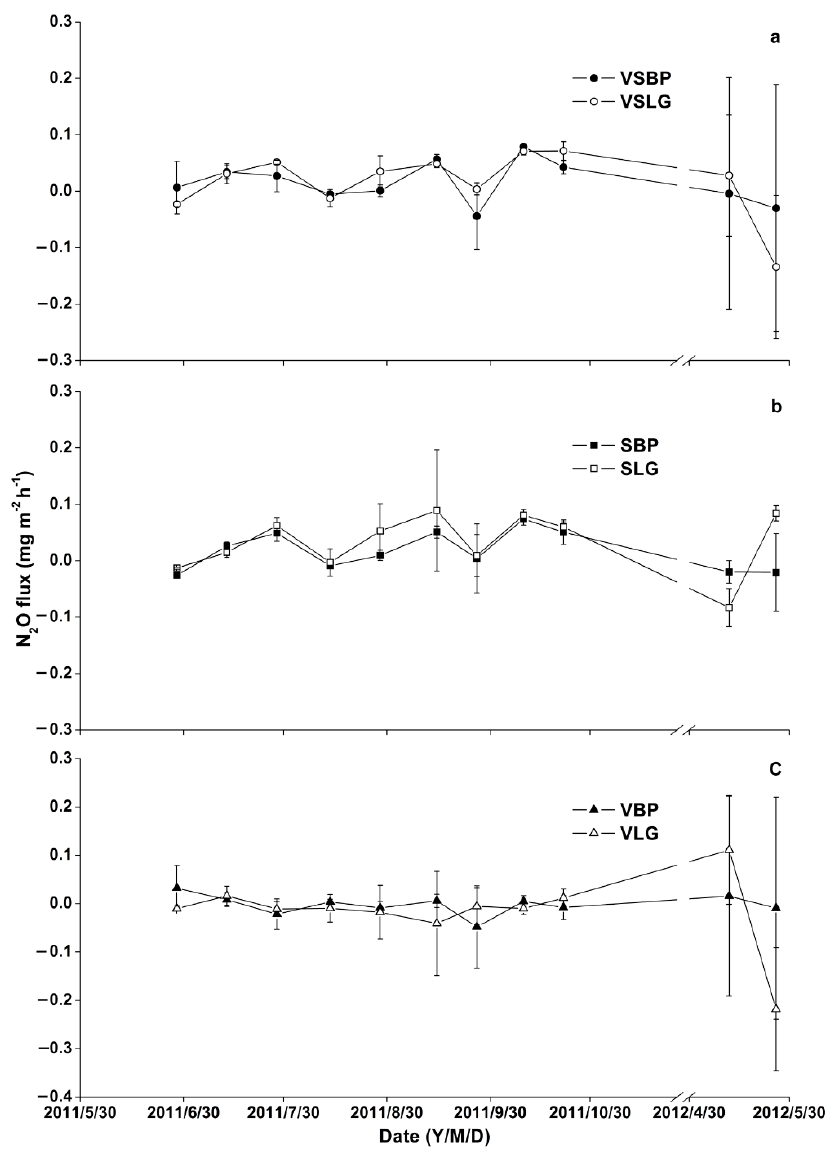
Figure 2. Seasonal variation of N 2 O fluxes from bare soil after removing vegetation under BP, abbreviated as SBP, bare soil after removing vegetation under LG, abbreviated as SLG, soil with vegetation under BP, abbreviated as VSBP, soil with vegetation under LG, abbreviated as VSLG, fluxes from the vegetation under BP, abbreviated as VBP, and under LG, abbreviated as VLG. ( a ) Temporal variation of N 2 O fluxes from VSBP and VSLG; ( b ) temporal variation of N 2 O fluxes from SBP and SLG; ( c ) temporal variation of N 2 O fluxes from VBP and